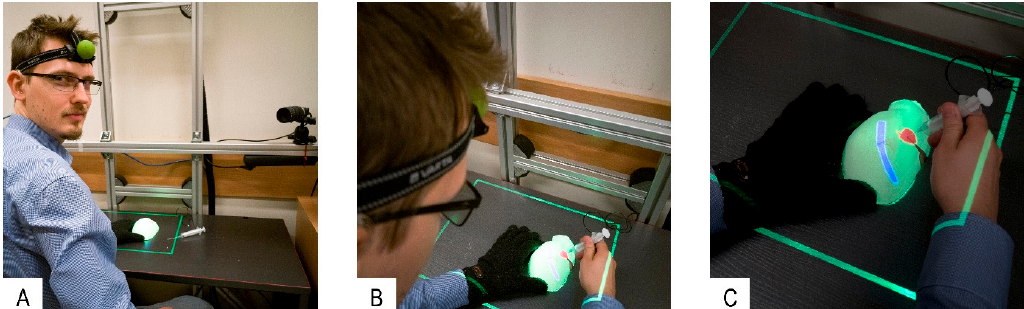
Figure 16. Setup and validation of MARVIS system. ( A )—Experimental setup showing author R.G. preparing the system for tests with the HdTM marker on his forehead. ( B )—Performance of validation tests. ( C )—Detailed projection view. The green border indicates that pose detection was paused